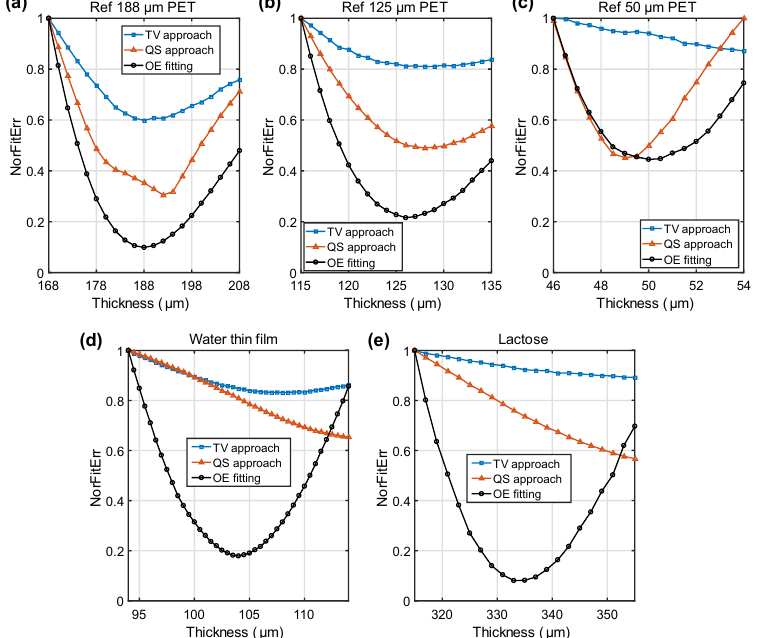
Figure A1. The NorFitErr (Normalized Fitness Error) as a function of thickness. The minimum values correspond to the optimized thickness found from different techniques. The results of the PET thin film with a reference thickness of ( a ) 188 μm, ( b ) 125 μm , and ( c ) 50 μm, and the results of the ( d ) water and ( e ) lactose thin film by the TV (Total Variation), QS (Quasi-Sapce), and OE fitting methods are shown for a comparison.